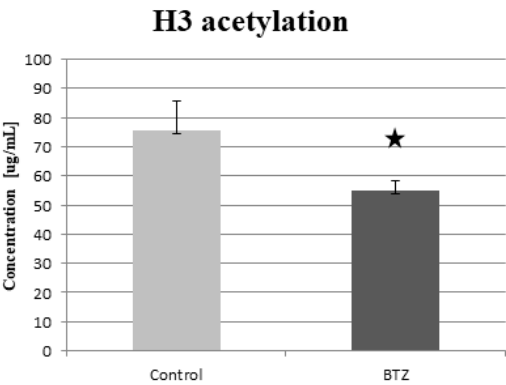
Figure 7. The concentration of global acetylated histone H3 in dLUHMES cells treated with BTZ and in the control cells. * p < 0.05.